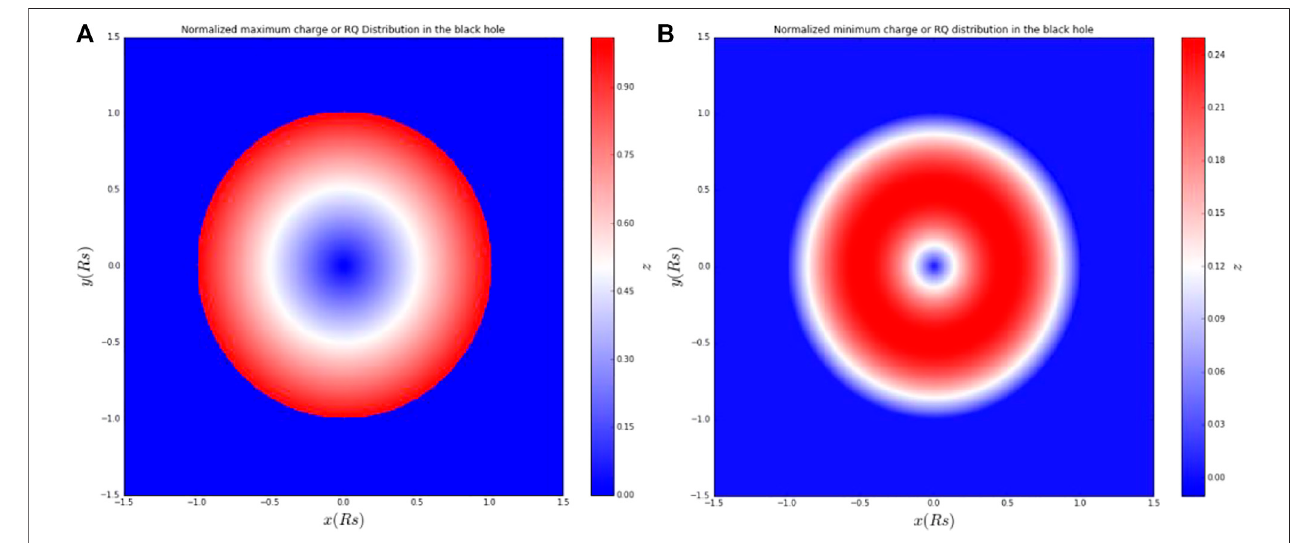
FIGURE 2 | (A) Minimal distribution of R Q and (B) the maximal distribution of R Q varying with the radial distance r for very small a . The color bar is in units of R S .